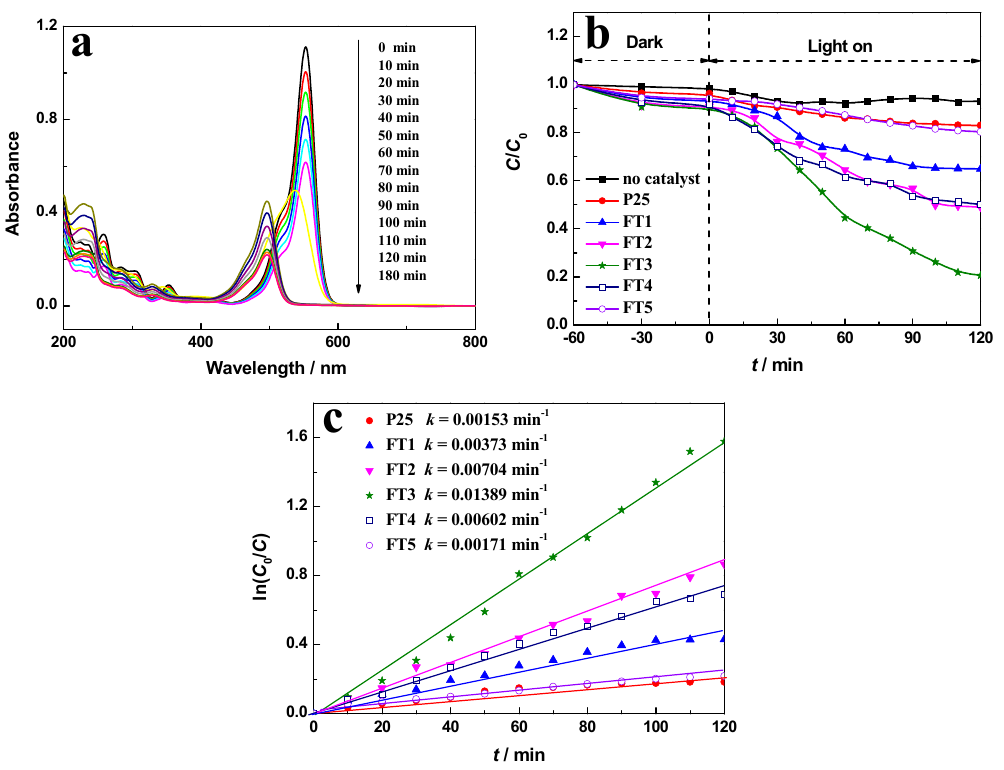
Figure 7. ( a ) Absorption spectra of 5 × 10 − 5 mol/L Rhodamine B (RhB) solution in the presence of FT3 under visible light irradiation at different irradiation times denoted by the different color lines; ( b ) degradation rate of RhB at the different intervals; and ( c ) ln( C 0 / C ) versus t curves in the presence of various photocatalysts.